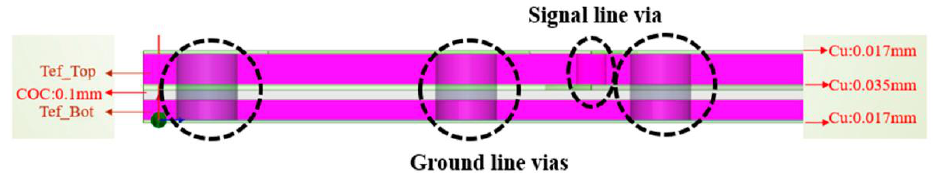
Figure 13. Simulation setup for insertion loss investigation.